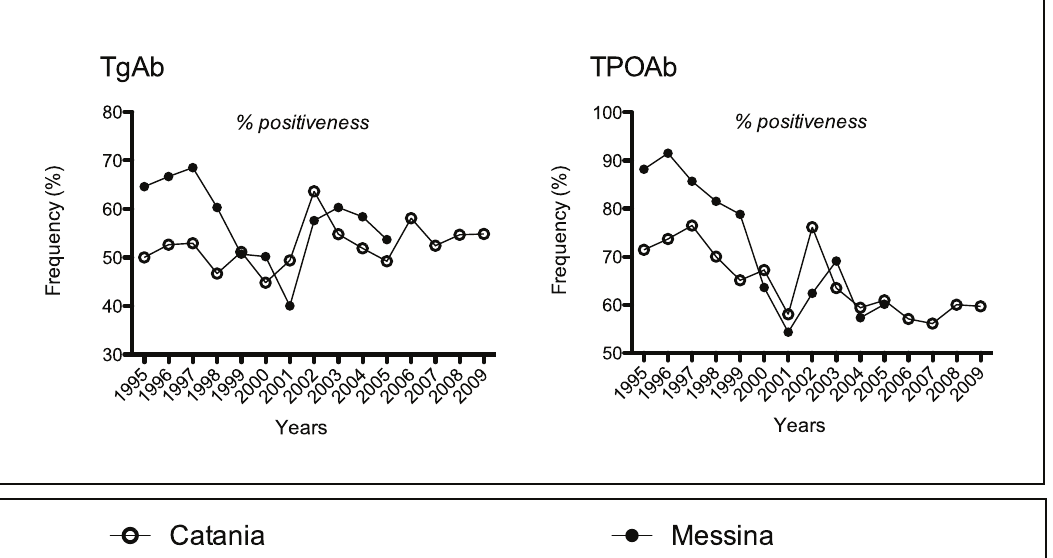
Figure 5. Yearly prevalence of the serum positiveness for thyroglobulin autoantibodies (TgAb, left panel) and thyroperoxidase autoantibodies (TPOAb, right panel), viz. proportion of patients with higher-than-normal serum levels of TgAb and TPOAb, in the two cohorts of patients with Hashimoto’s thyroiditis.